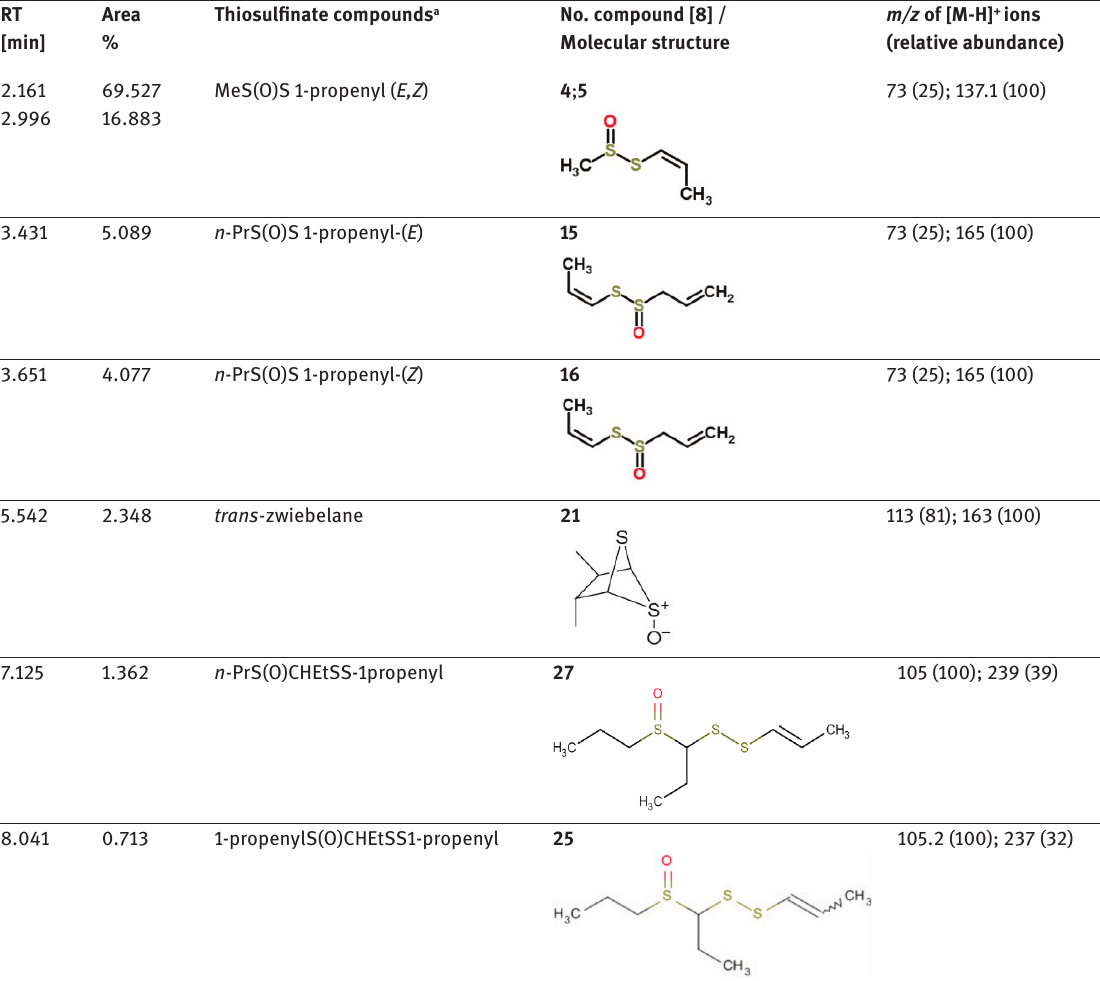
Table 2: Thiosulfinate compounds identified in the formulation based on A. cepa lyophilized extract.